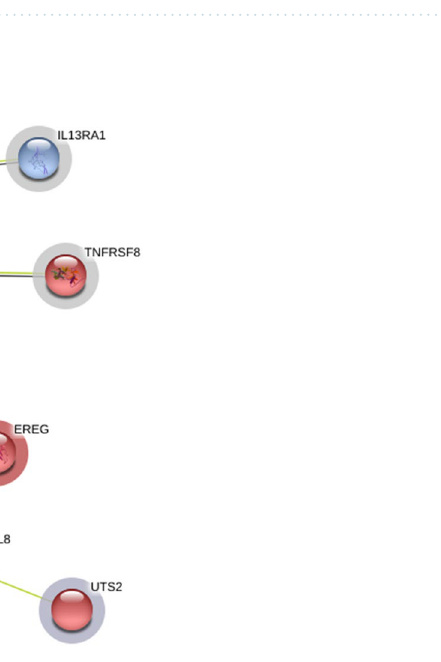
Figure 3. GO pathway enrichment analysis of dysregulated genes in peripheral blood of young females with TMJ OA. A total of 16 GO terms ( P < 0.01) including 3 molecular and 13 biological terms were annotated using the GO function of molecular function and biological process.